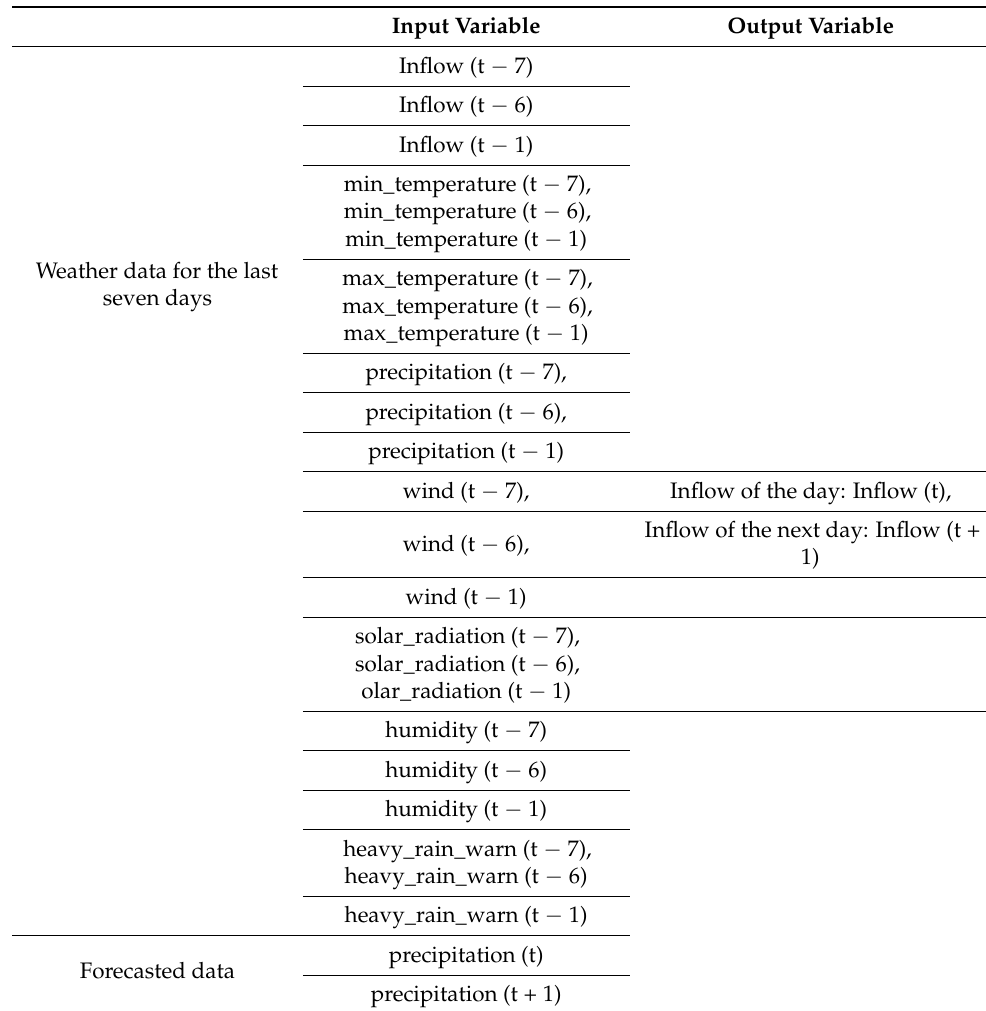
Table 1. Input data for the proposed and baseline